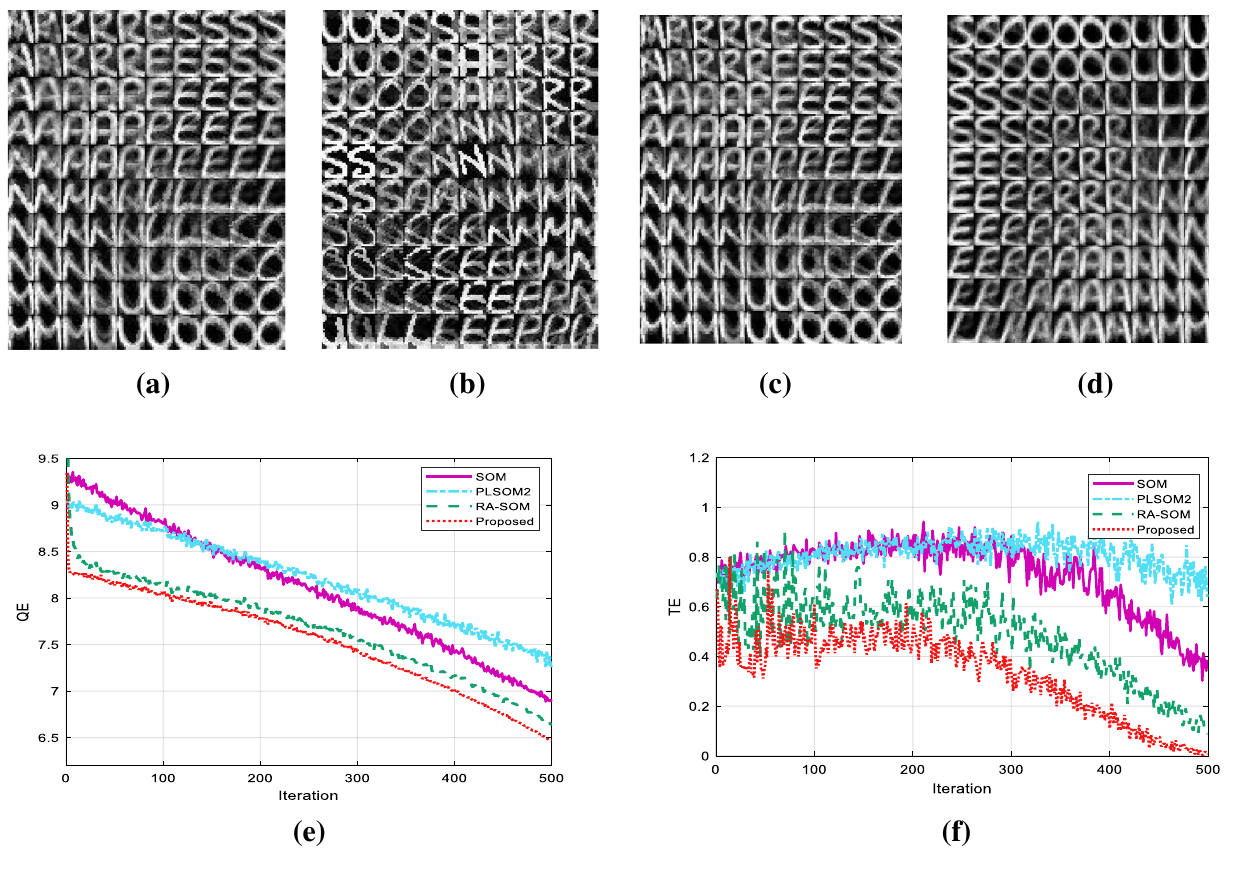
Fig. 6 Learning performance comparison of conventional SOM, PLSOM2, RA-SOM and proposed VLR-SOM algorithms using handwritten digits random initialization with 500 iterations: a Neighborhood construction behavior for Conventional SOM,